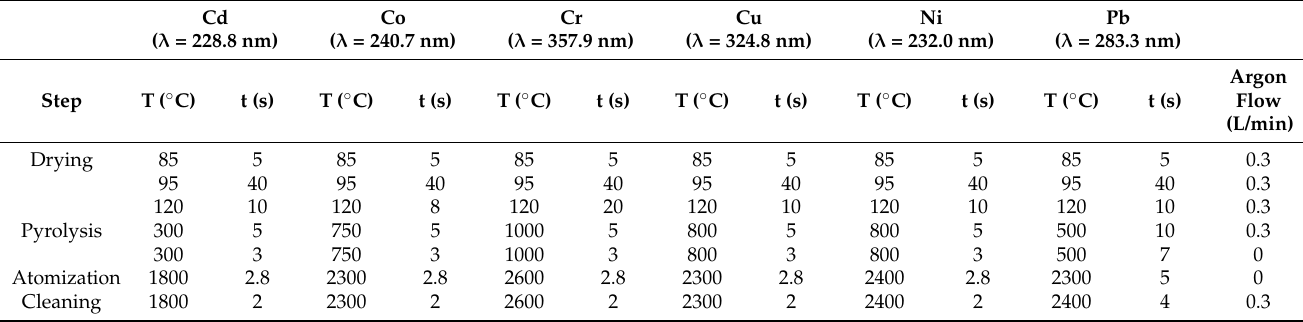
Table 1. Instrumental conditions for Cd, Co, Cr, Ni and Pb analysis by ET-AAS in Brassicaceae samples.